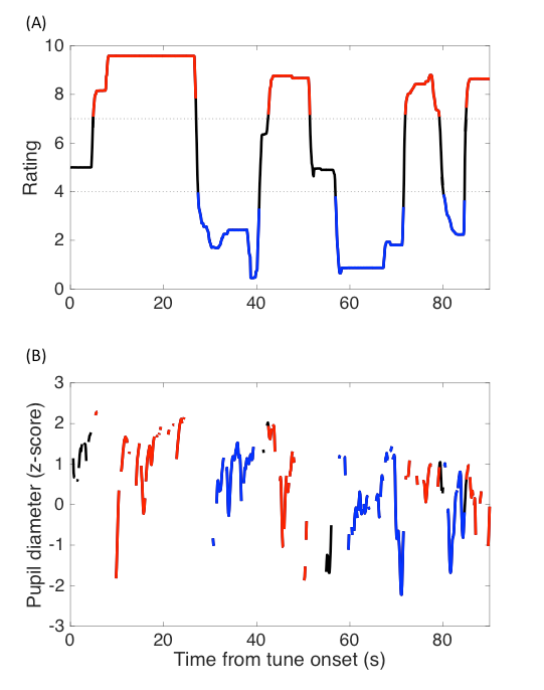
Fig. 1. Examples of on-line surprise rating (A) and pupil size change (B) over time. The red and blue lines represent the surprising and unsurprising moments, respectively, as defined as when the rating score was above 7 or below